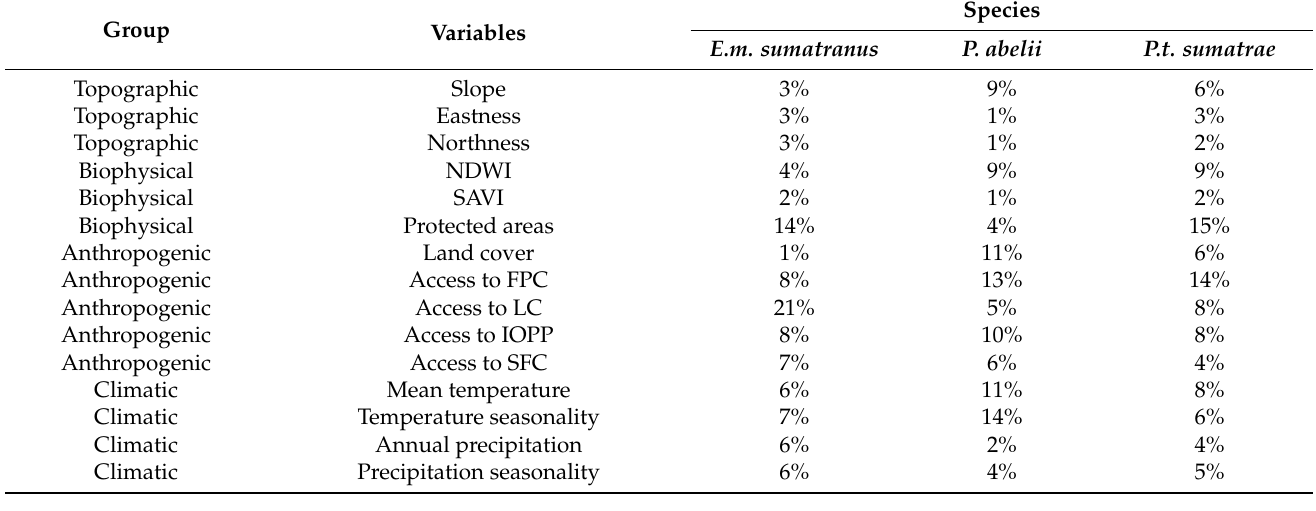
Table 1. Contribution of each variable for the best model (Ensemble).